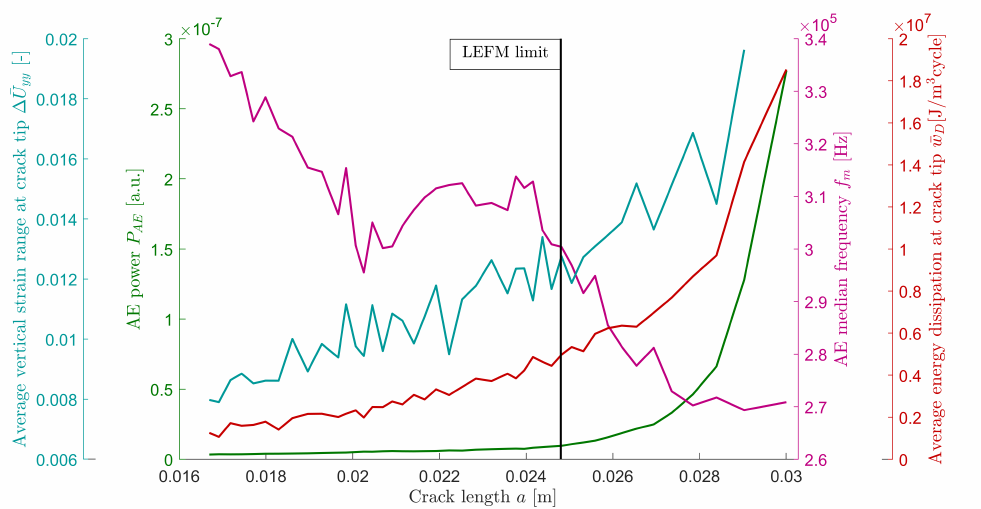
Figure 19. Characterisation of fatigue crack propagation by a combination of IRT, DIC/RVI, and AE techniques. The vertical line indicates the LEFM SSY limit according to Equation (24).